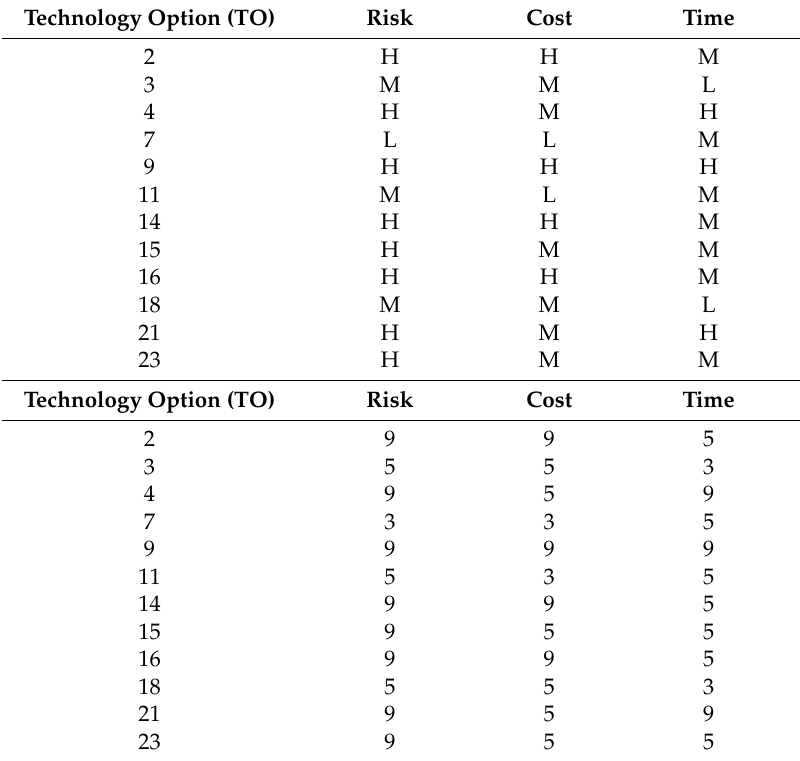
Table 4. Final result of assessed TOs from the top-left zone of the portfolio. Technology Option (TO) Risk Cost Time